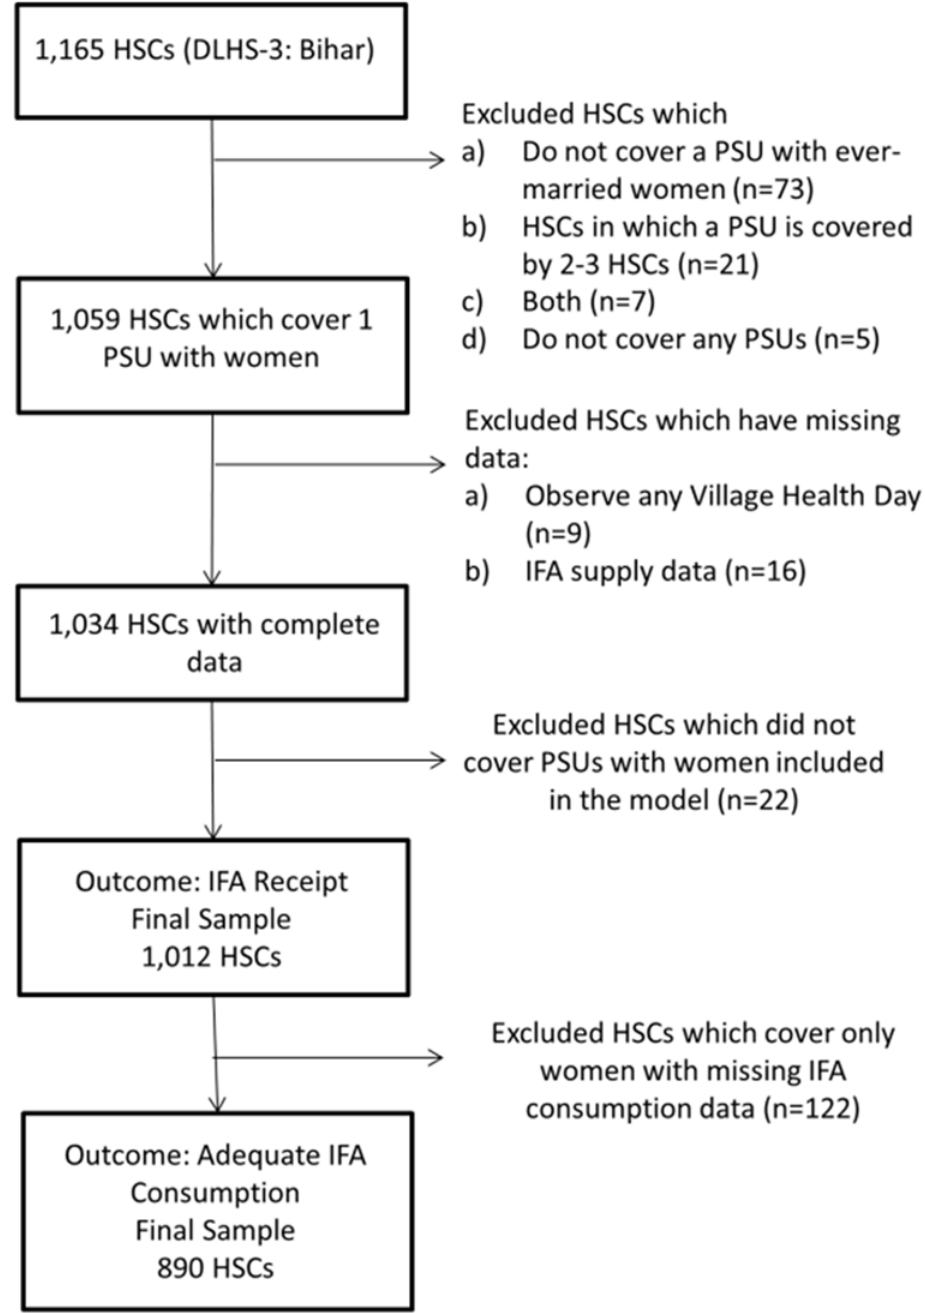
Fig 2. Flowchart of Health Sub-Center exclusions and final sample. Flowchart of exclusions and final sample of health sub-centers surveyed in Bihar through DLHS-3. HSC: Health Sub-Center; DLHS: District Level Household Survey; PSU: Primary Sampling Unit; IFA: iron and folic acid tablets or